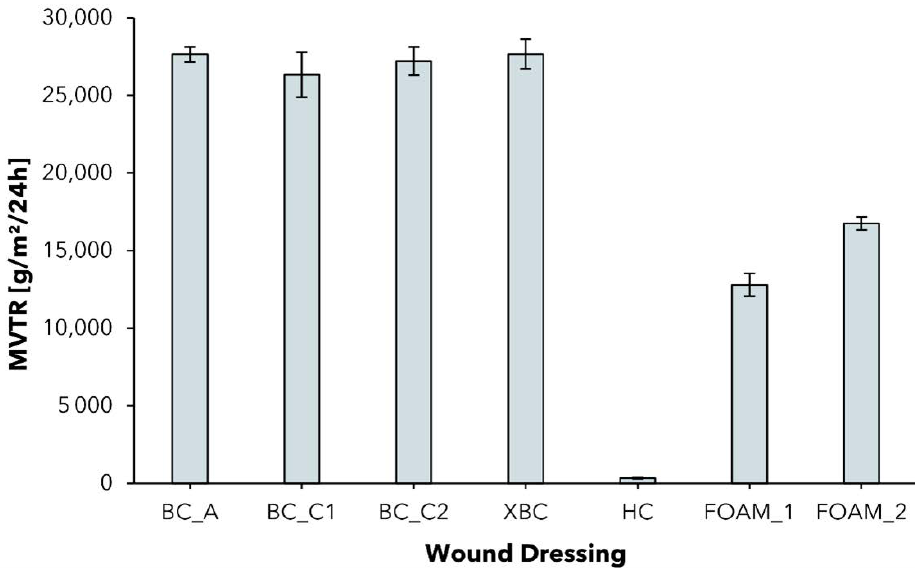
Figure 5. Moisture vapor transmission rate (MVTR) of different wound dressings determined with standard Paddington cup in contact with liquid method (mean ± SD; n = 5).